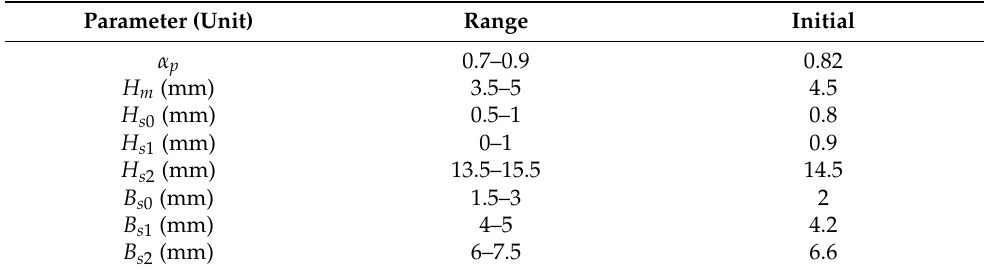
Table 2. Initial values and range of values of structure parameters.